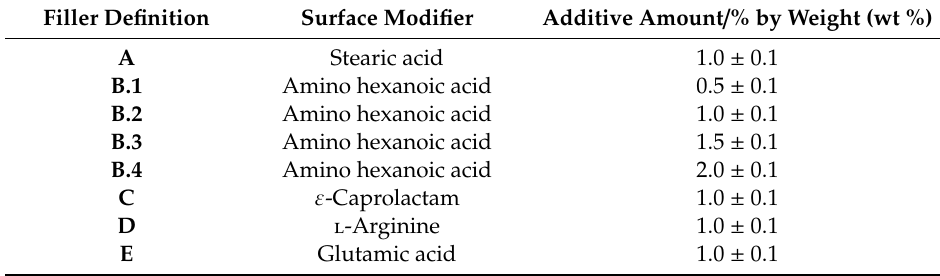
Table 3. Resulting functional filler data after drying